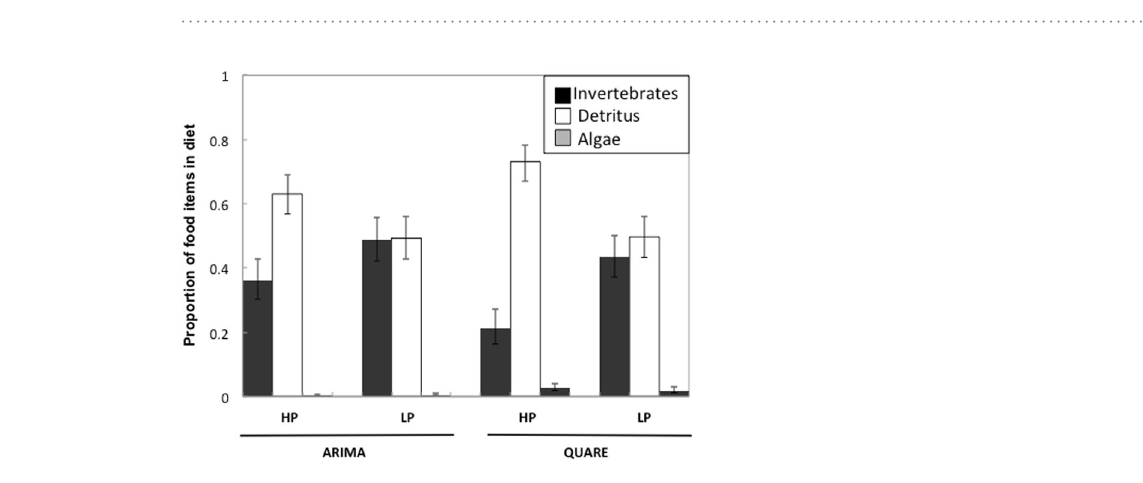
Table 1. Characteristics of the 10 surveyed sites. “R” is for Rivulus hartii , “G” is for guppy ( Poecilia reticulata ), and “na” is not available.